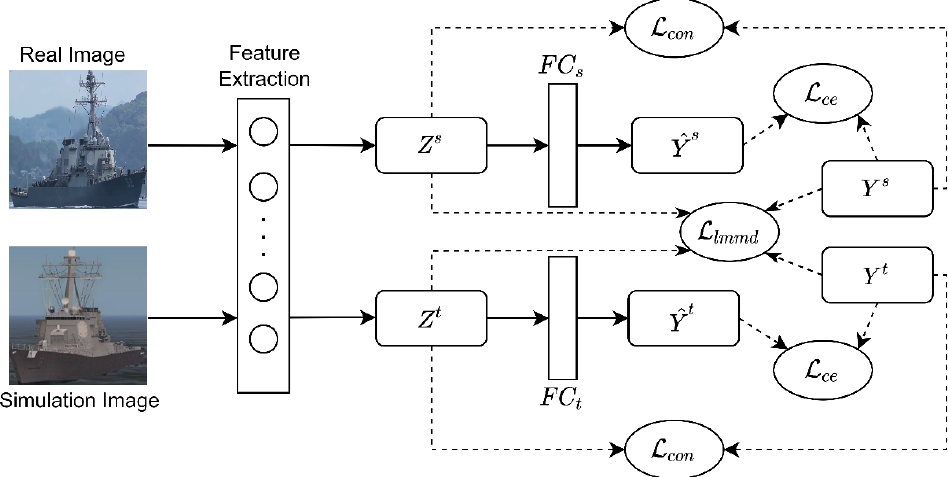
Figure 7. The architecture of training recognition model based on domain adaptation.